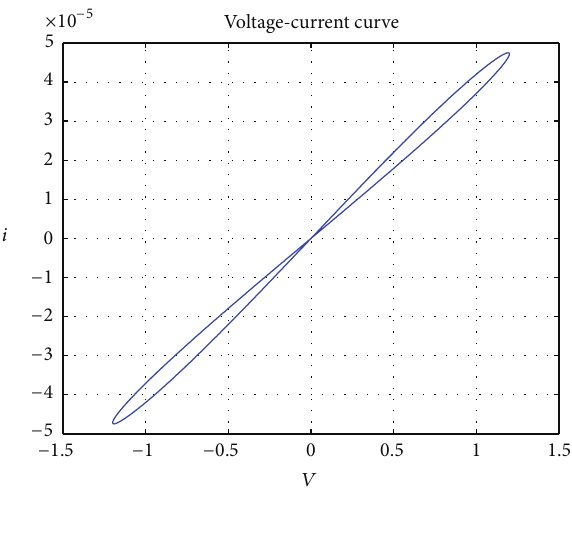
Figure 4: The V - I characteristics of memristor. Figure 5: (a) Flux of meminductor; (b) current of